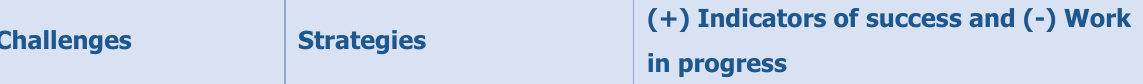
Table 7. Key Personnel—Teens as Teacher Essential